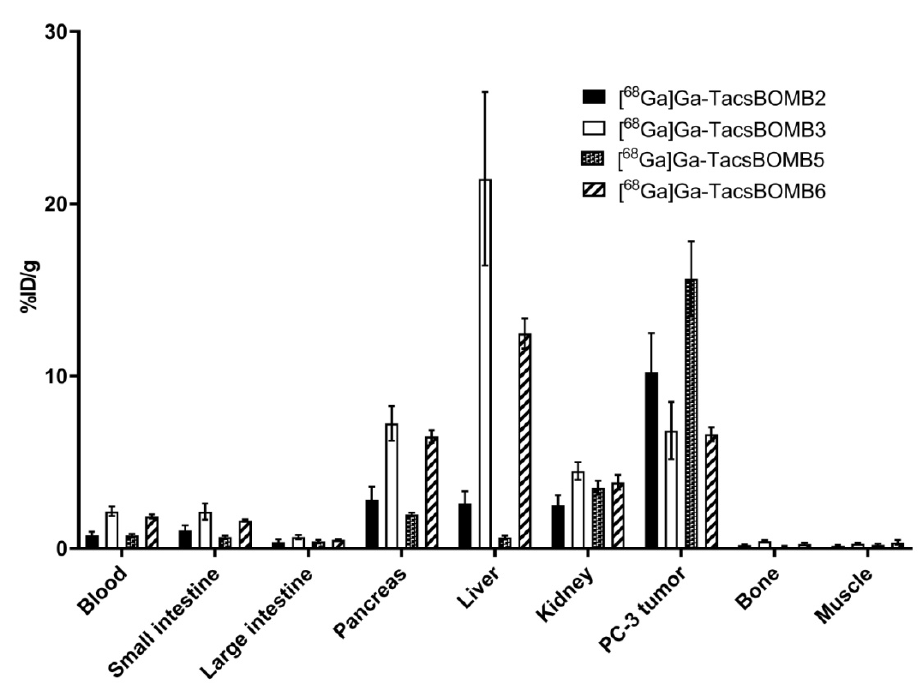
Figure 5. Uptake of [ 68 Ga]Ga-TacsBOMB2, [ 68 Ga]Ga-TacsBOMB3, [ 68 Ga]Ga-TacsBOMB5, and [ 68 Ga]Ga-TacsBOMB6 in PC-3 tumor xenografts and major organs/tissues of mice at 1 h post-injection. Error bars indicate standard deviation.